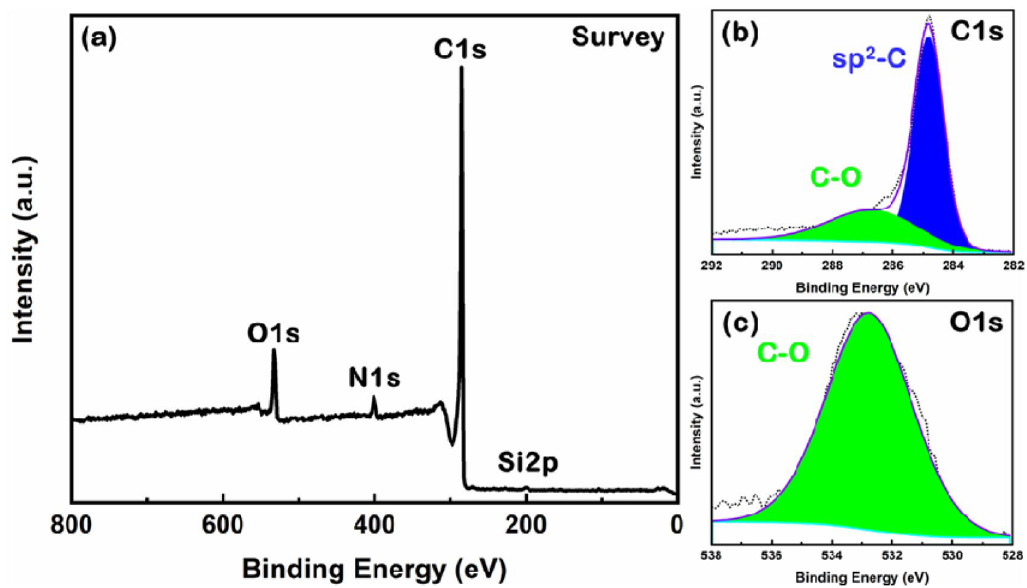
Figure 3. XPS analysis: ( a ) survey scan, high resolution deconvoluted ( b ) C1 & ( c ) O1s spectra for nettle leaves 1:1